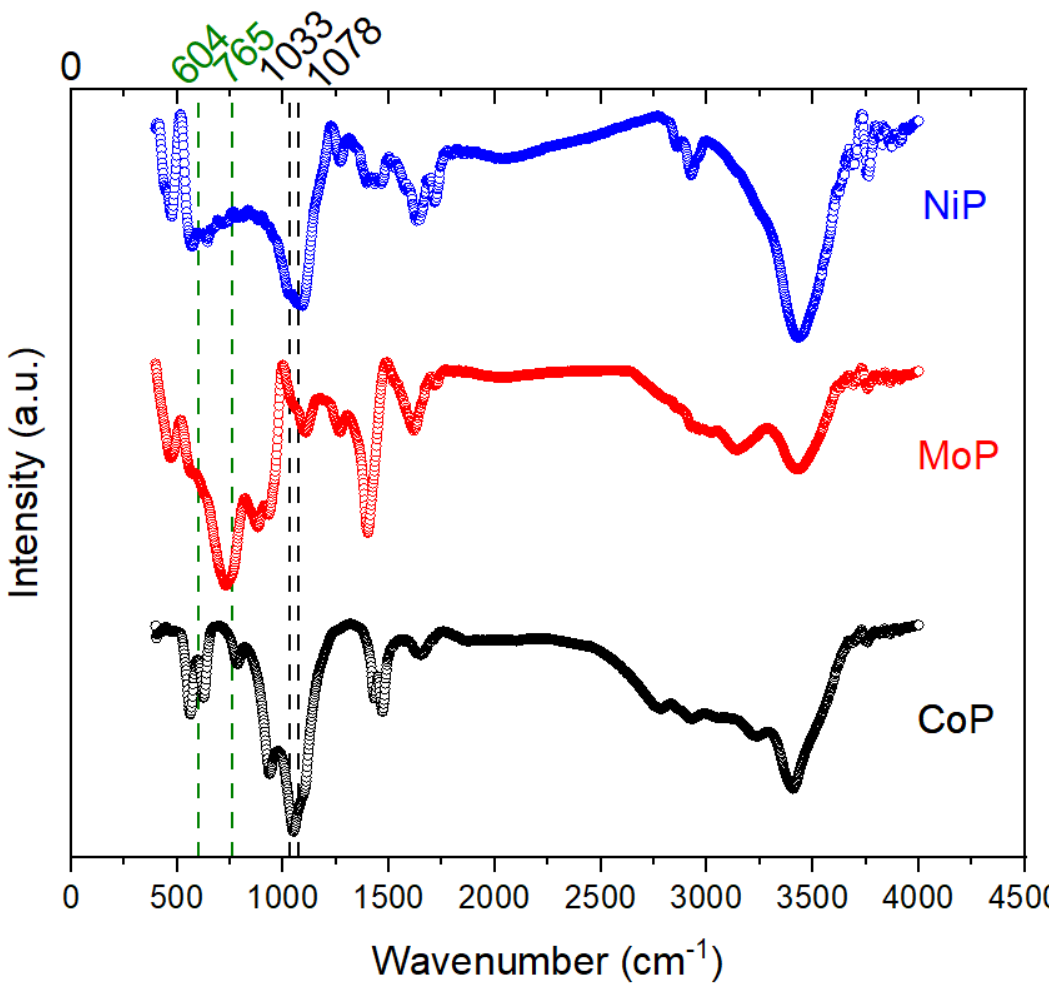
Figure 4. FTIR spectrum for each phosphide specimen prepared.